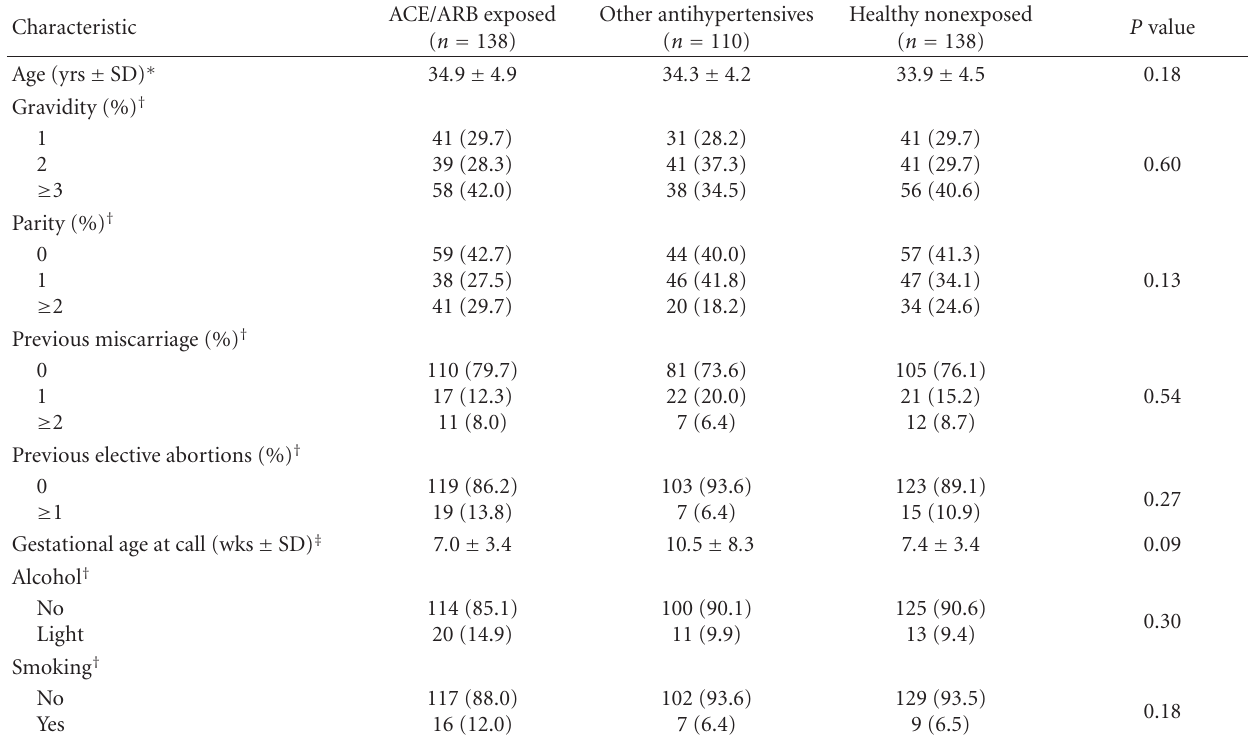
Table 1: Characteristics of included subjects.